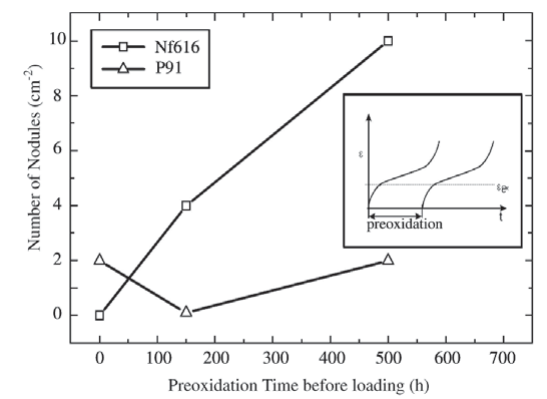
Figure 17. Number of iron rich fast growing nodule lines at scale cracks per square centimetre after the creep tests as a function of preoxidation